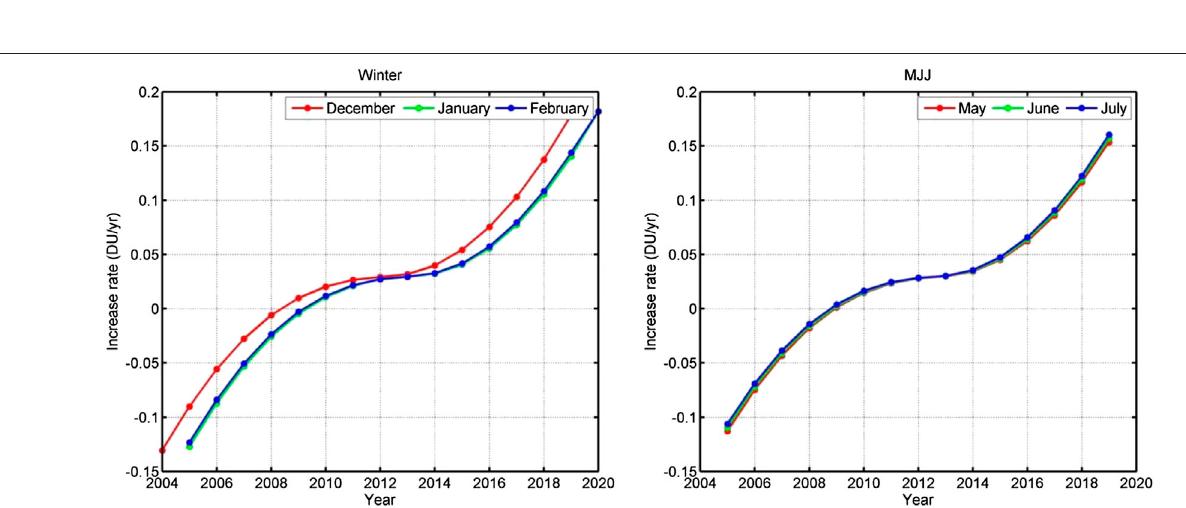
FIGURE 7 | Variation of ozone de fi cit over the TP in winter (left) and early summer (right).